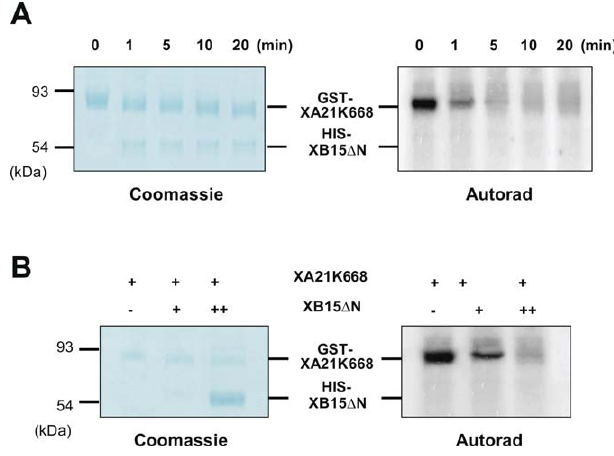
Figure 9. XB15 Dephosphorylates the XA21 Kinase Domain (A) Immobilized GST-XA21K668 was autophosphorylated with [ c - 32 P] ATP in kinase buffer. After washing, activated GST-XA21K668 was incubated with HIS-XB15 D N (1 l g) at 37 8 C for the indicated time (0, 1, 5, and 20 min). The samples were subsequently boiled in the presence of 2 3 sample buffer, separated by SDS-PAGE, stained with Coomassie brilliant blue R250 and destained (Coomassie). For the autoradiography, the dried gel was exposed to an image plate (Autorad). (B) Activated GST-XA21K668 was incubated with 1 l g ( þ ) or 10 l g ( þþ ) of HIS-XB15 D N at 37 8 C for 5 min. The samples were subsequently boiled in the presence of 2 3 sample buffer, separated by SDS-PAGE, stained with Coomassie brilliant blue R250 and destained (Coomassie). For the autoradiography, the dried gel was exposed to an image plate